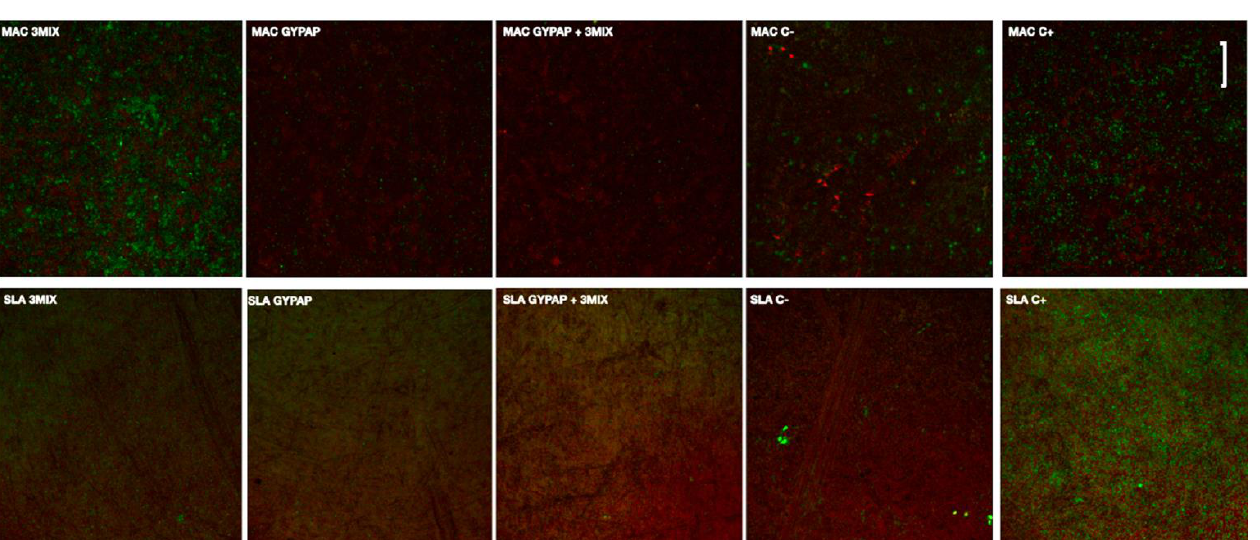
Figure 2. Confocal laser scanning microscopy (CLSM) images of the machined (MAC) and acid etched surface (SLA) titanium surfaces with two different decontamination protocols. The scale bar was set to 10 microns.